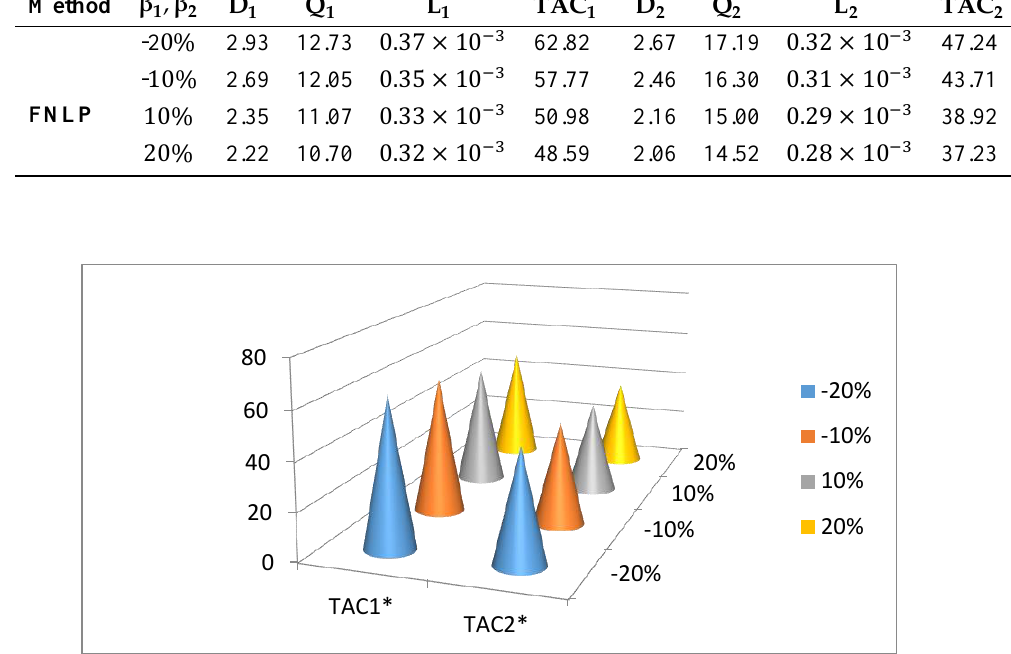
Fig. 4. Minimizing cost of 1 st and 2 nd items for different values of 𝛃 𝟏 , 𝛃 𝟐 .